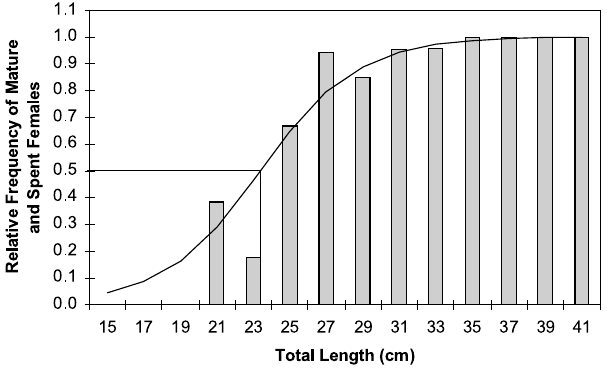
Fig. 1 . Relative frequency of mature and spent females of Menticirrhus littoralis by size class. Animals captured